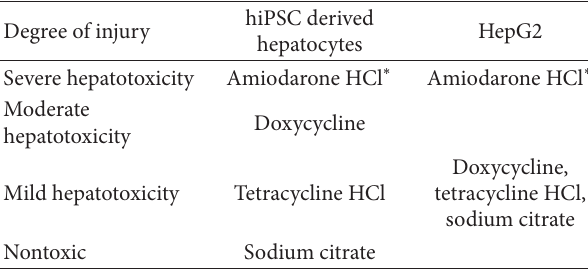
Table 4: Categorizing compounds based on their degree of injury at isomolar concentration of 100 𝜇 M for each parameter